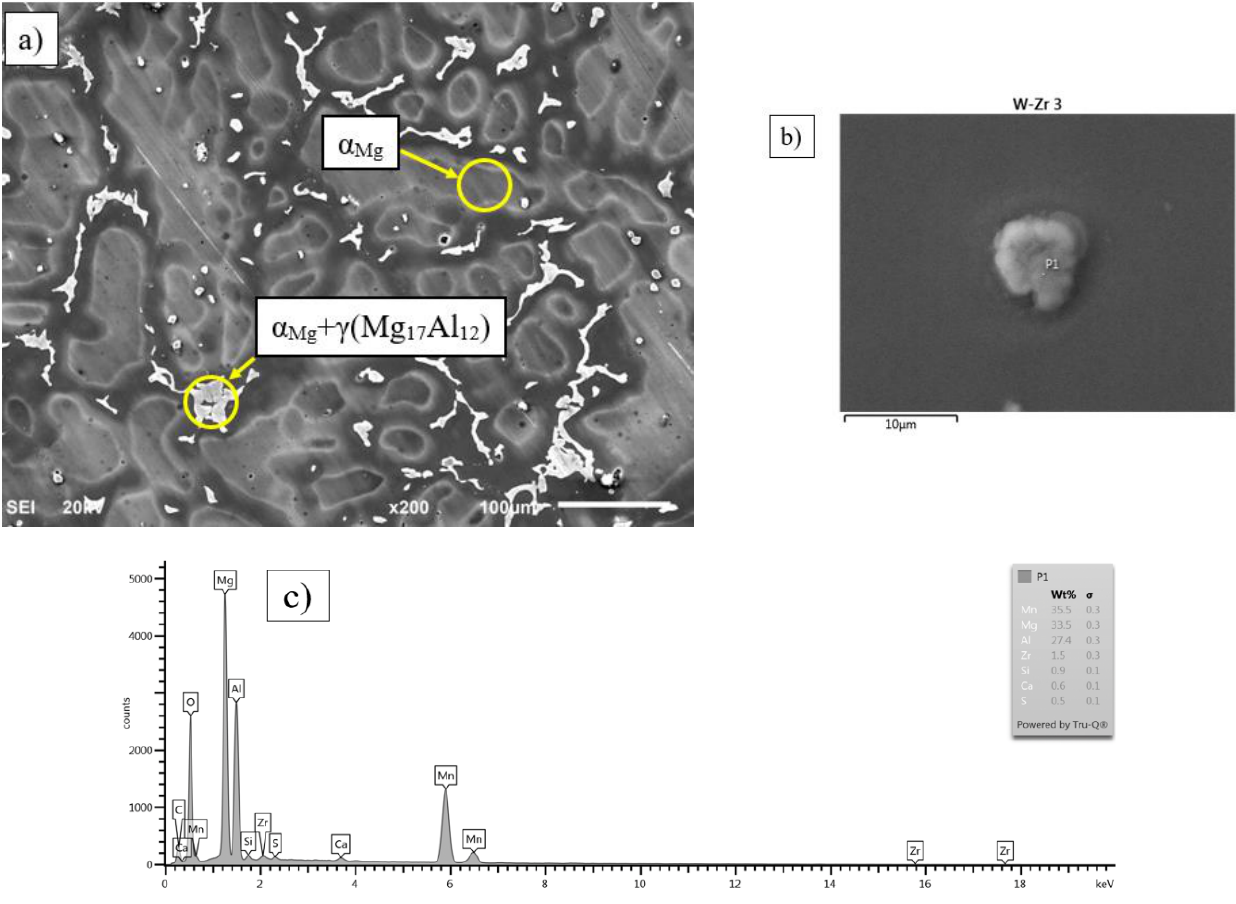
Table 5. Results of the chemical composition analysis of the AZ91 with 0.3 wt % of Zr taken at the point P1 in Figure 7b.